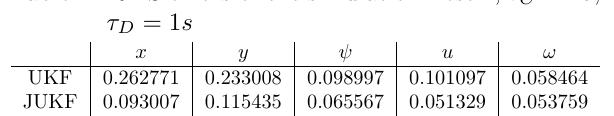
Table 2: RMS errors of the simulation Test 2, τ C = 2 s ,